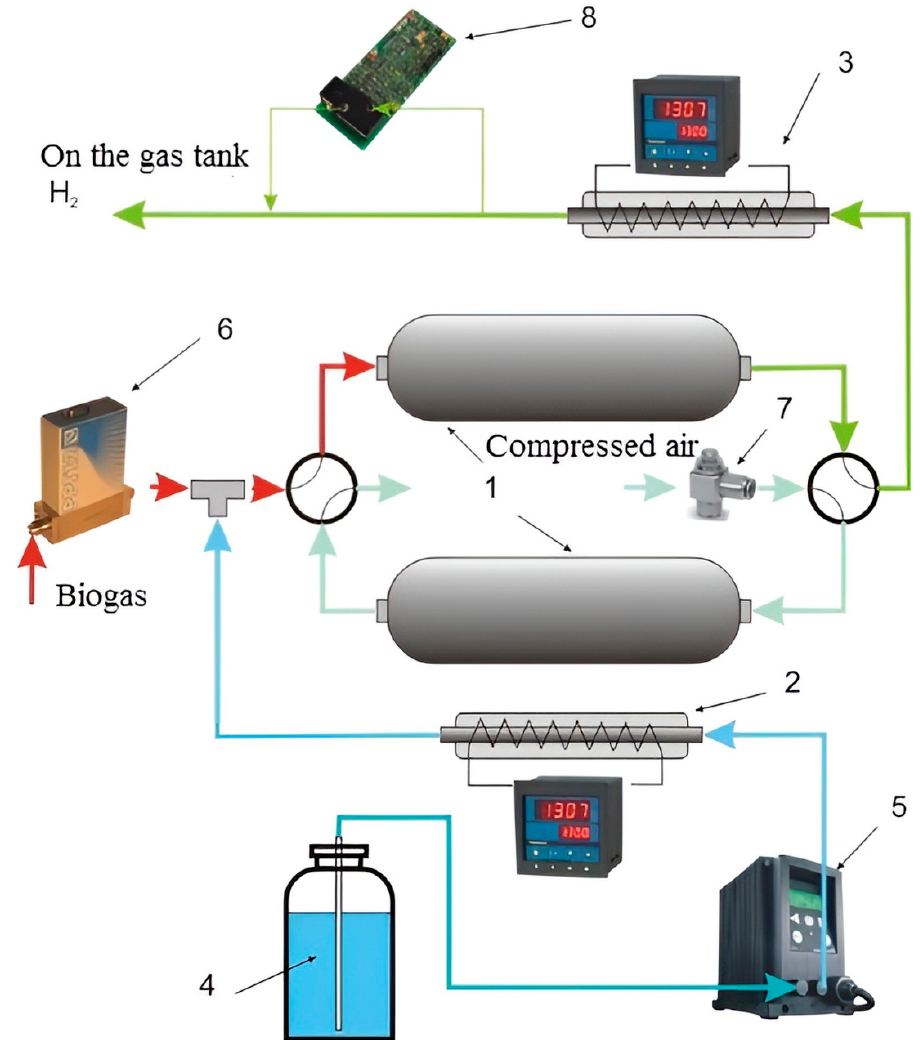
Figure 3. Scheme of the reformer module: 1—adsorption-catalytic blocks; 2—evaporator with temperature controller; 3—methanator; 4—distillate; 5—liquid pump; 6—gas flow regulator; 7—gas throttle; 8—methane concentration control.